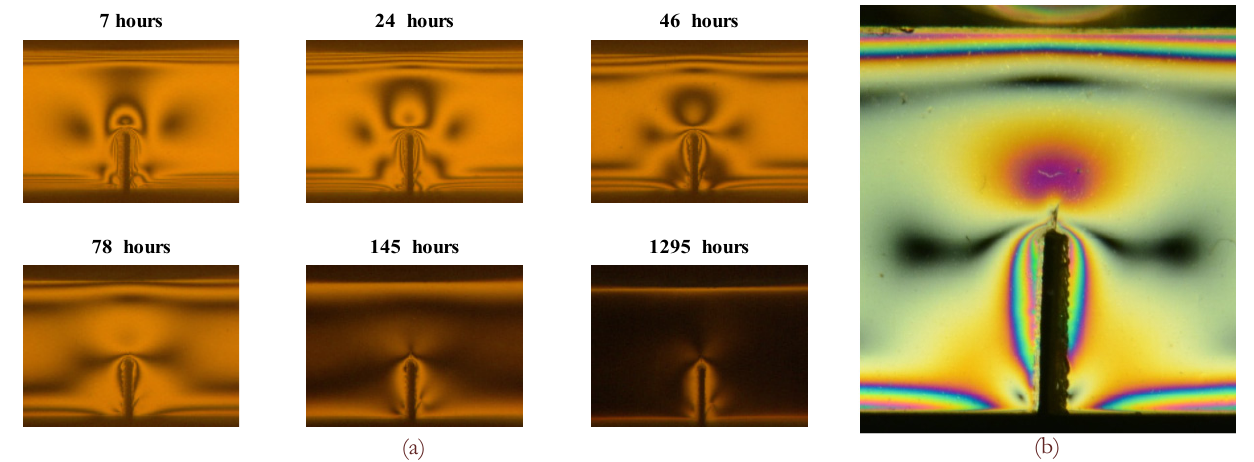
Figure 4: (a) Evolution with aging time of isochromatic maps from SENB samples, acquired with a dark field circular polariscope in monochromatic light; (b) particular of the notched zone, acquired in white light, after 48 hours